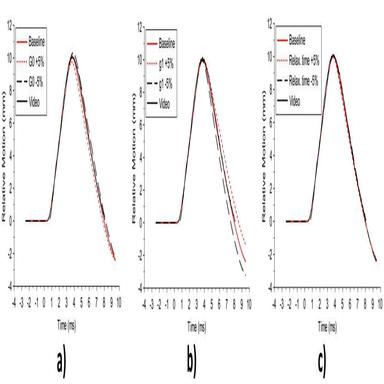
Sensitivity of model to errors in the derived parameters (τ1,G0, g1). Results shown are for Sylgard 3–6636 (1:2) at an impact velocity of 2.40 m/s.